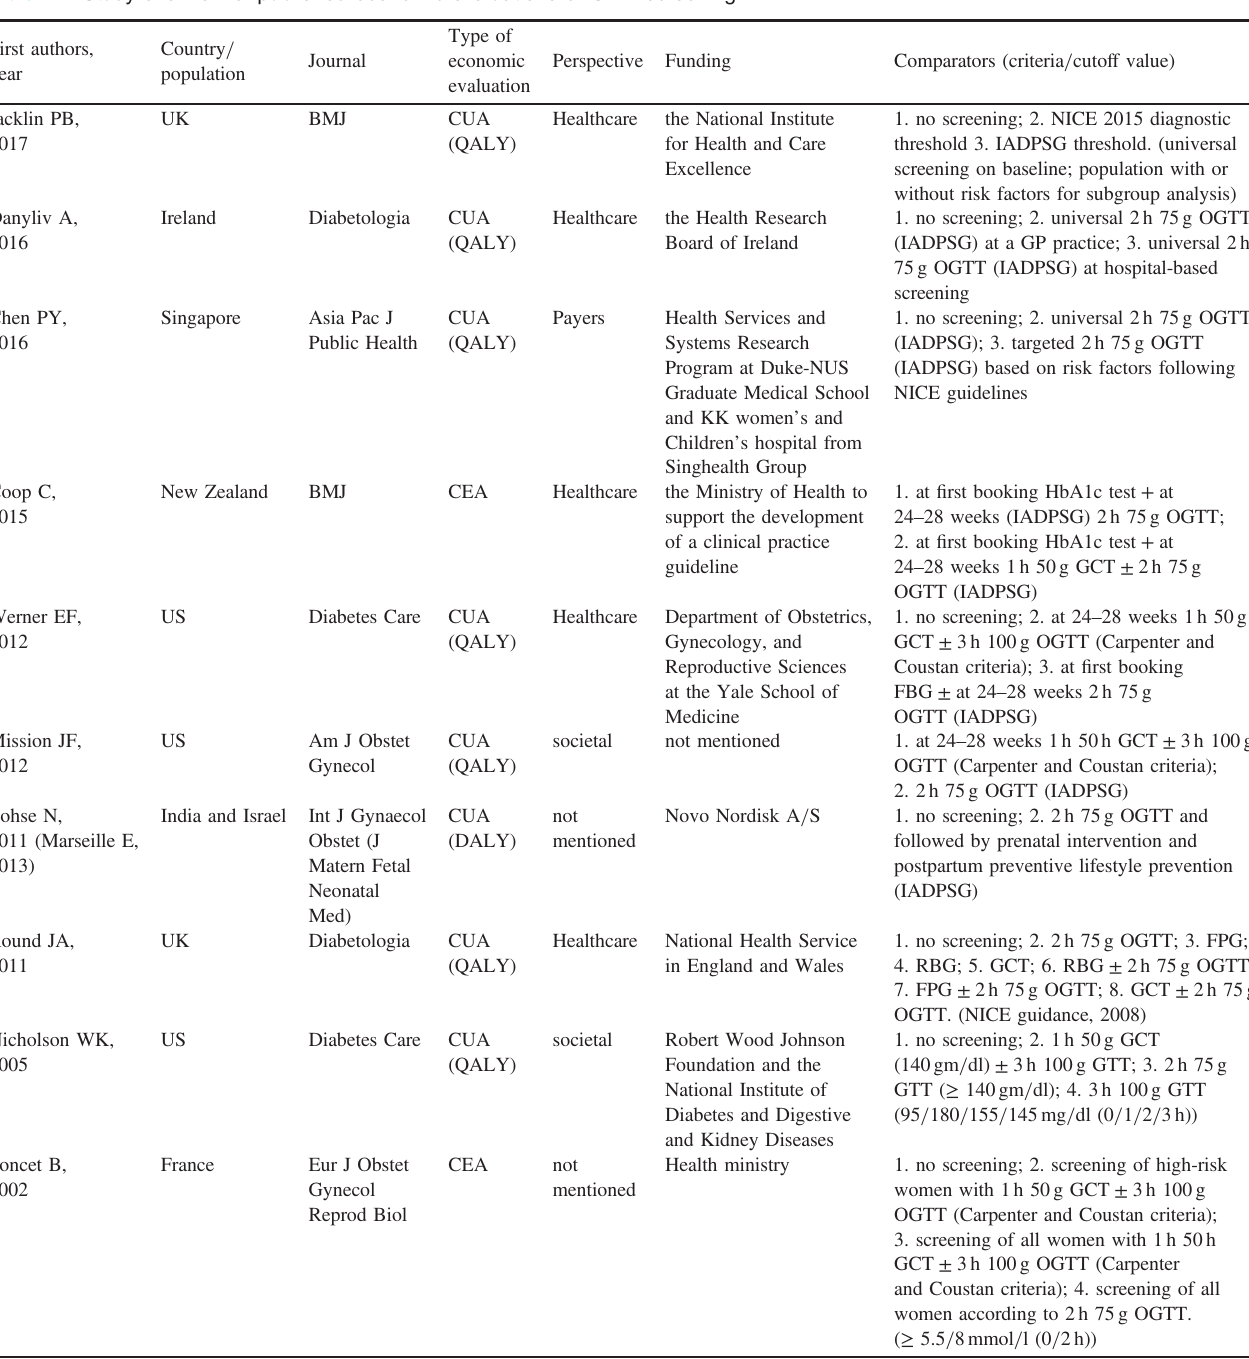
Table 2. Study overview of published economic evaluations of GDM screening First authors,